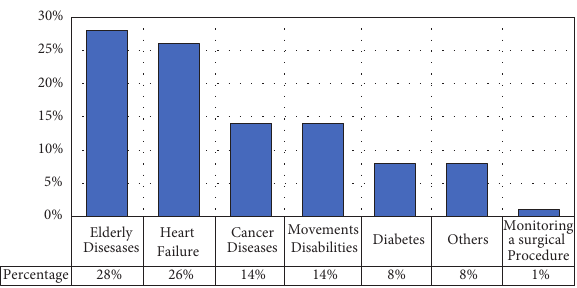
Figure 3: Distribution of RPM according to